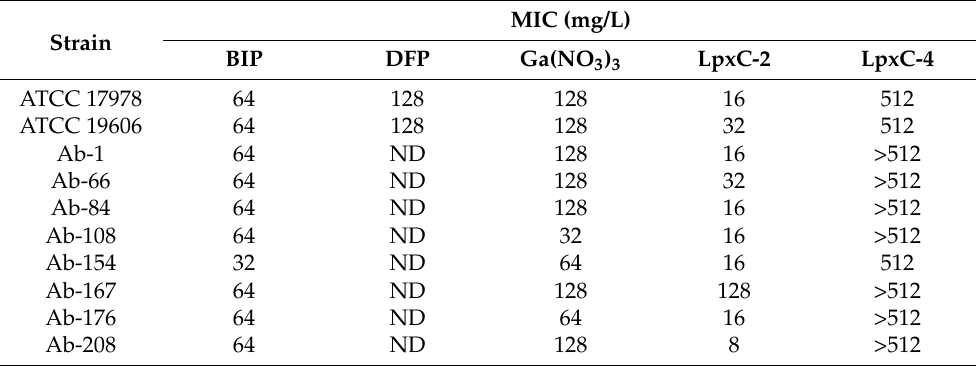
Table 1. MICs of iron chelators, gallium nitrate and LpxC inhibitors for a A. baumannii strains used in this